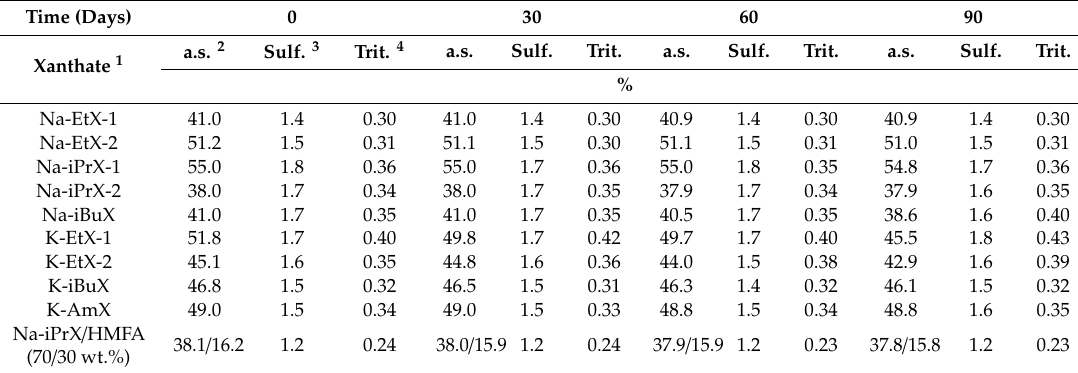
Table 9. Results of the stability test of the synthesized alkyl